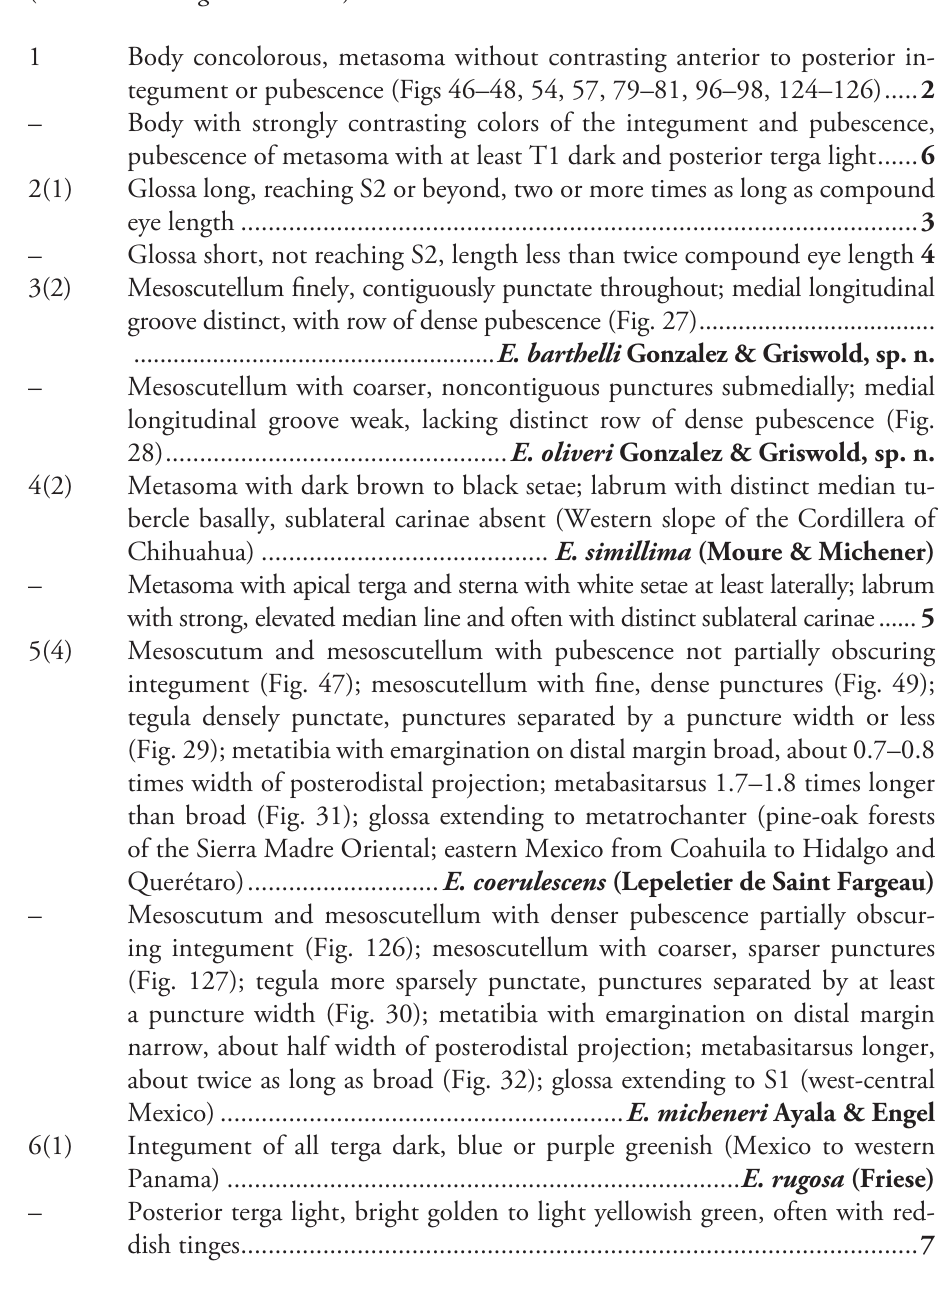
a puncture width (Fig. 30); metatibia with emargination on distal margin narrow, about half width of posterodistal projection; metabasitarsus